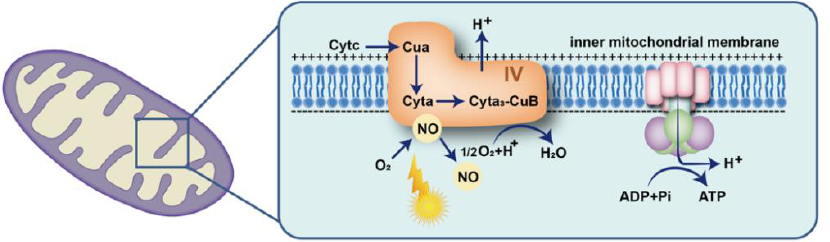
Figure 1. Schematic representation of the influence of light on intracellular redox levels. Photon energy facilitates the dissociation of nitric oxide (NO) from the binding site of cytochrome C oxidase and subsequently promotes oxygen binding to the dissociated site, to enhance mitochondrial respiration and ATP generation.